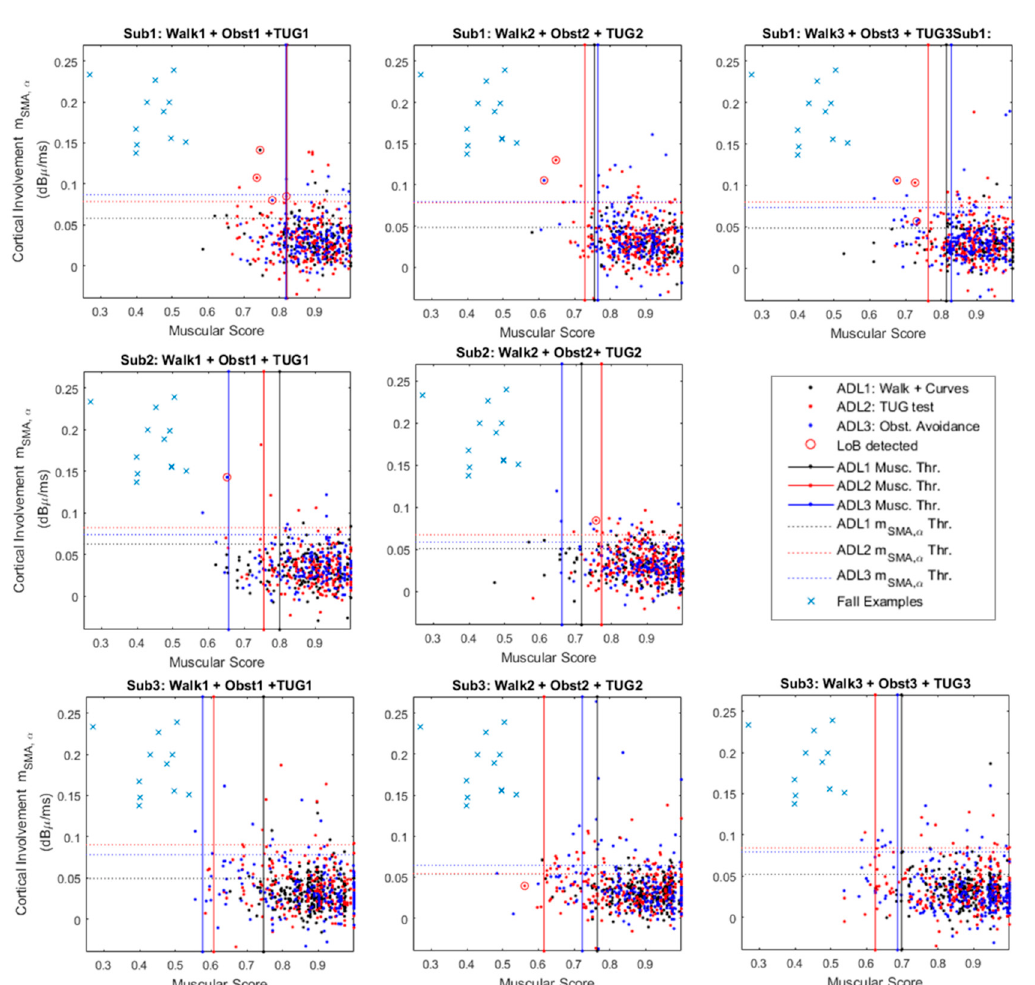
Figure 5. Cortico-muscular involvement planes for the 3 analyzed subjects. The figure merges contractions from three different Activities of Daily Life (ADL): curves (black), timed up and go (TUG) test (red) and obstacle avoidance (blue). The panels show the false alarms (red circles) and a comparison group (blue crosses) that represents the typical values occurring during a fall-related master trigger (MT)